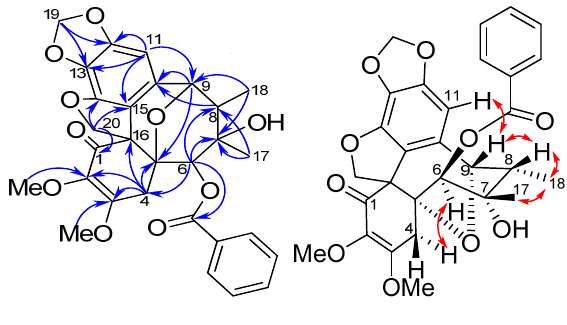
Figure 4. Selected HMBC (arrow) and NOESY (double headed arrow) correlations of 4